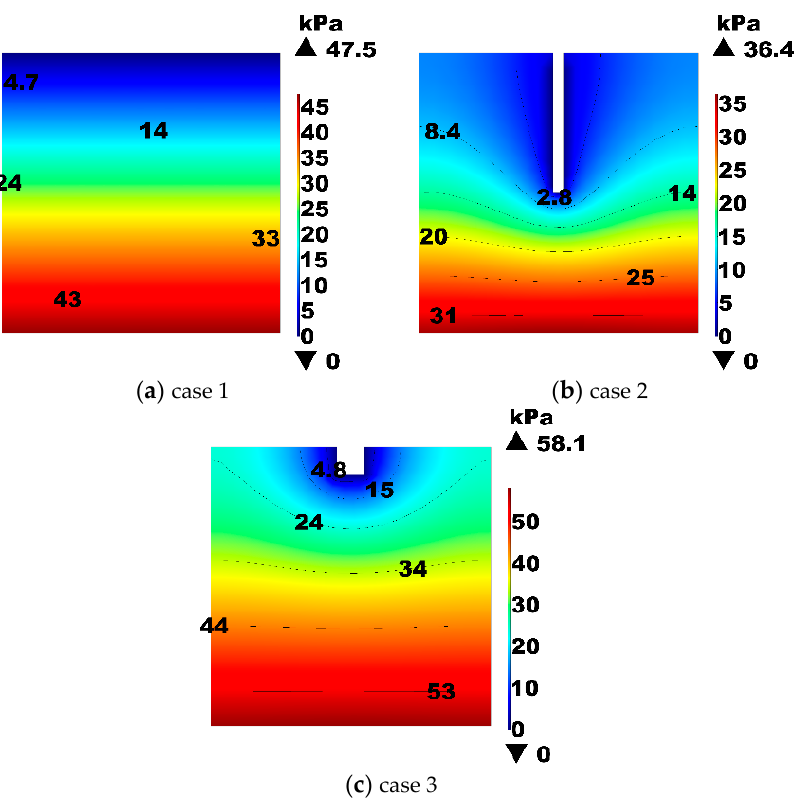
Figure 7. Pore gas pressure at the depth of 8 m in the landfill cell.